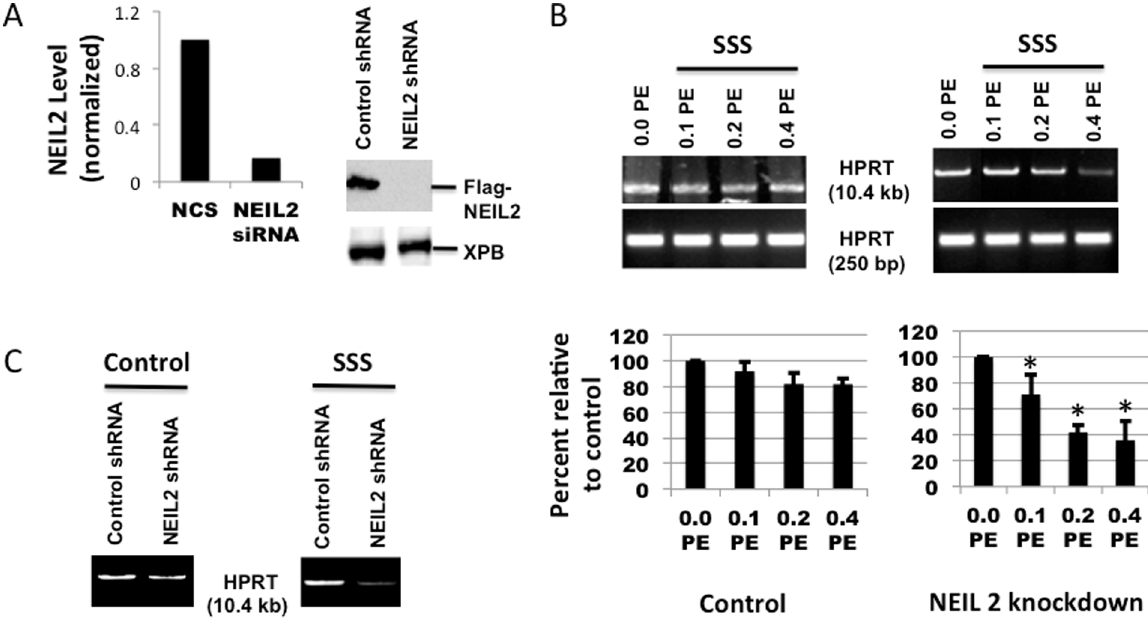
Figure 4. Effect of NEIL2 knockdown on induction of oxidative DNA damage by exposure to SSS for 24 h in the human HPRT gene using LA-QPCR. (A) left: NEIL2 knockdown from hPF was tested by qRT-PCR; right: Western blots showing shRNA-mediated knockdown of NEIL2 in HEK293 cells expressing Flag-NEIL2. (B) Cultured hPF with NEIL2 knockdown were treated with 3 doses of SSS extract as compared to the control followed by DNA isolation and digestion with Fpg and Nei as described in Materials and Methods. The DNA was used as template for HPRT large and short fragment amplification by LA-QPCR assay. The histogram depicts the mean % of DNA tail 6 SEM of 3 to 4 independent experiments. The symbol * means that the differences between the Control and NEIL 2 knockdown were statistically significant (P , 0.05); (C) HEK293 cells with NEIL2 knockdown without (left) or with (right) SSS treatment followed by HPRT large fragment amplification by LA-QPCR.